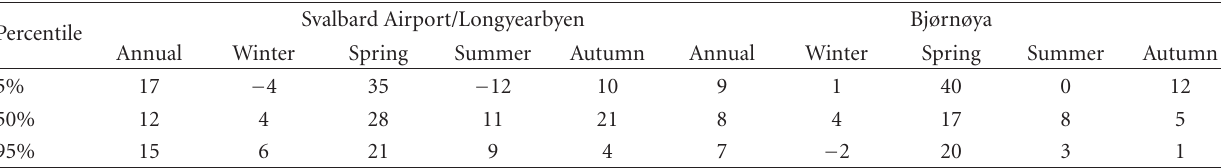
Table 7: Changes in 5-, 50-, and 95-percentile precipitation totals (%) from 1961–90 to 2071–2100 for Svalbard Airport and Bjørnøya. The projections are based on RCM simulations. Svalbard Airport/Longyearbyen Bjørnøya Percentile Annual Winter Spring Summer Autumn Annual Winter Spring Summer